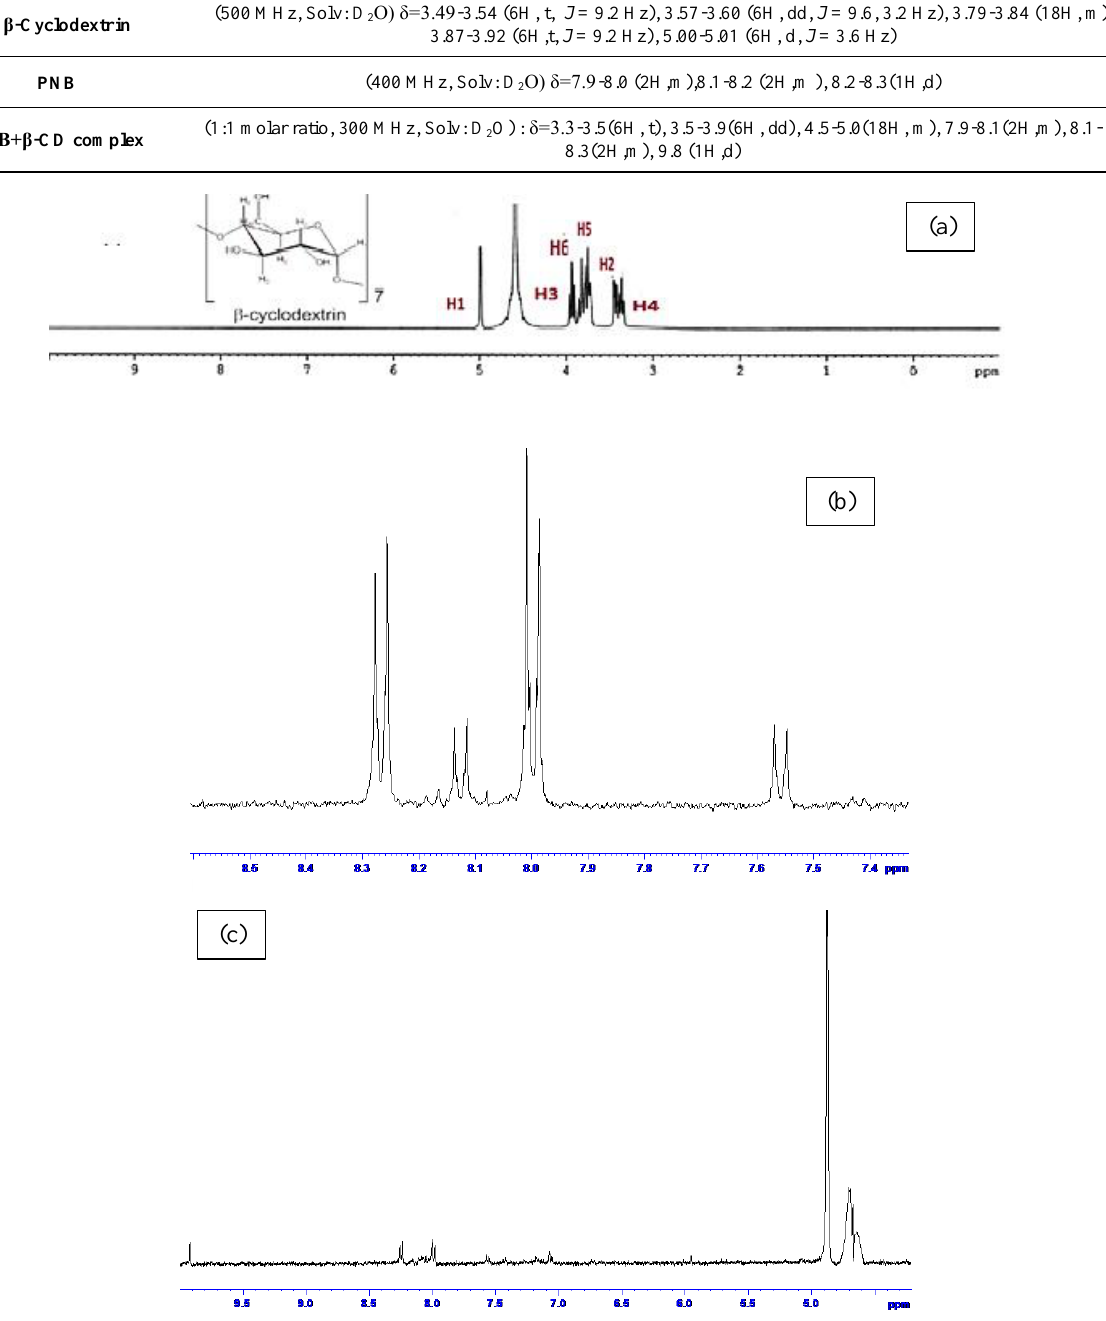
Figure 5. H NMR Spectra of (a) β-CD (b) PNB and (c) 1:1 molar ratio of β-CD + PNB in D 2 O in 298.15